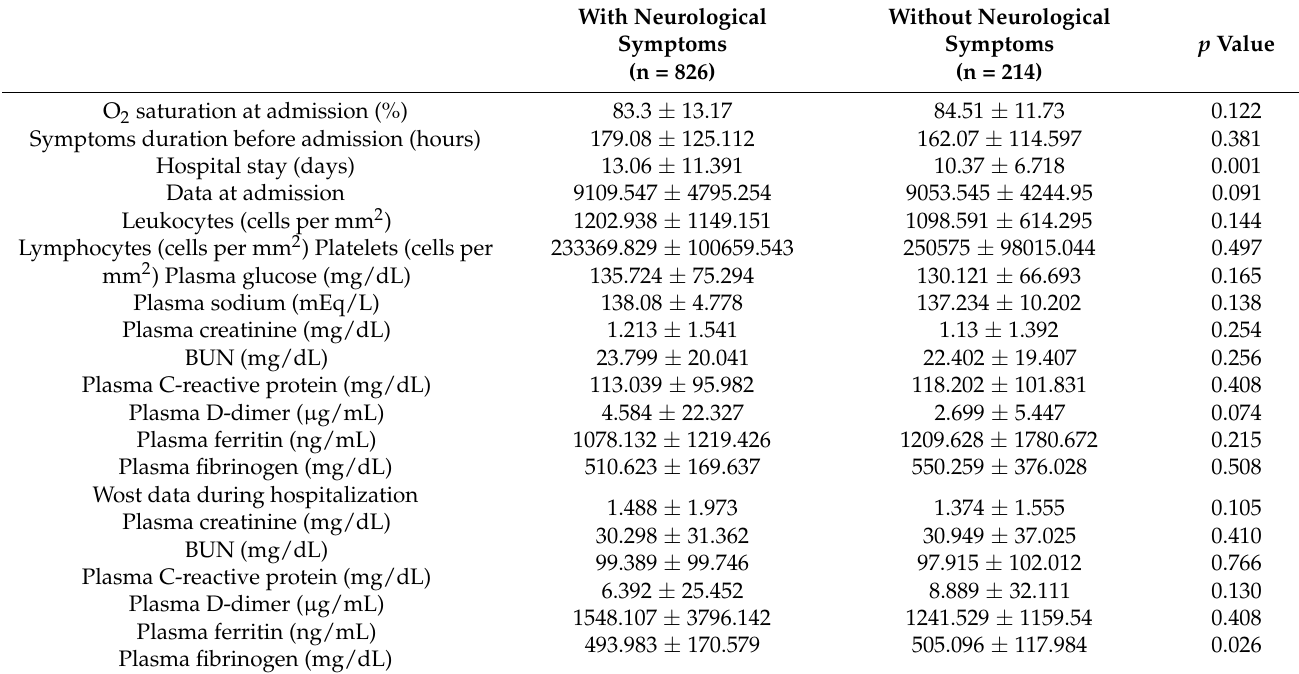
Table 3. Several clinical conditions and results of laboratory tests at admission and their worst levels during hospitalization.